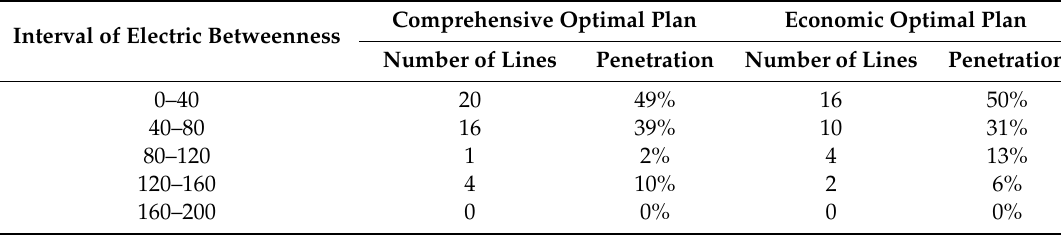
Table 7. Distribution of electric betweenness of